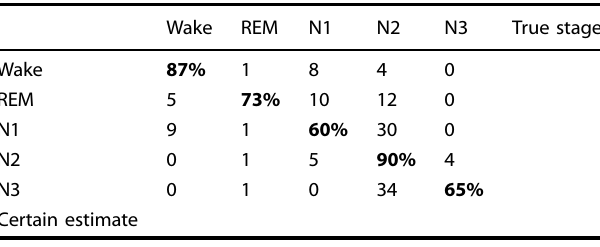
Values in bold represent uncertainty algorithm true-positive rate.